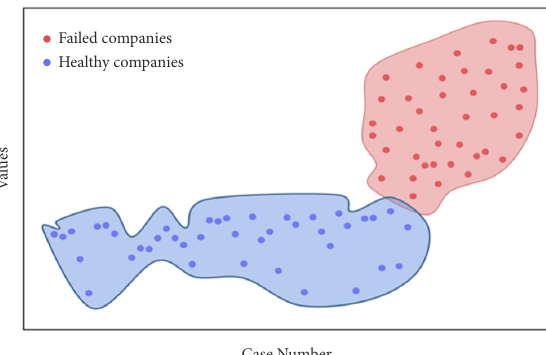
Figure 2. Casewise statistics (source: authors’